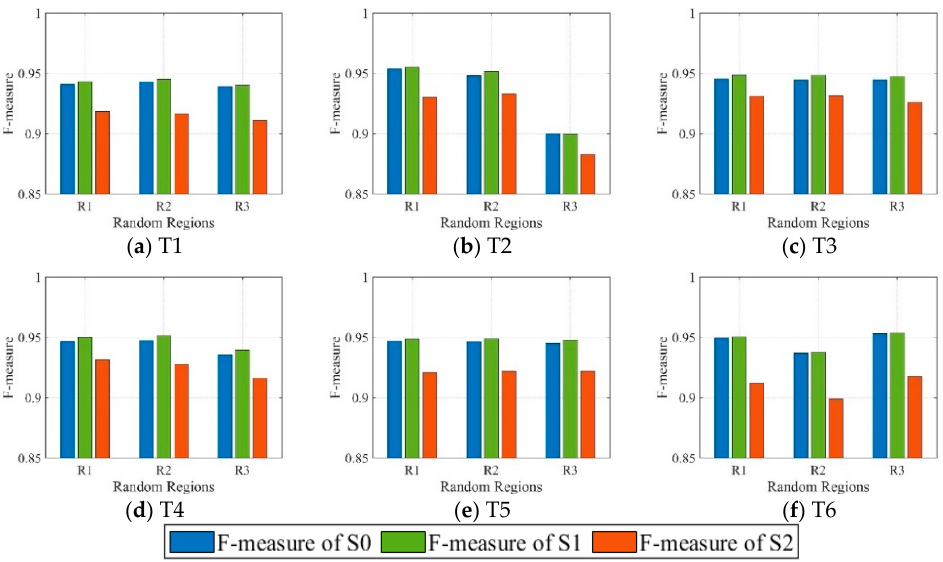
Figure 5. Accuracy assessment of three comparison strategies for random regions with the tile size 500 and step 25.